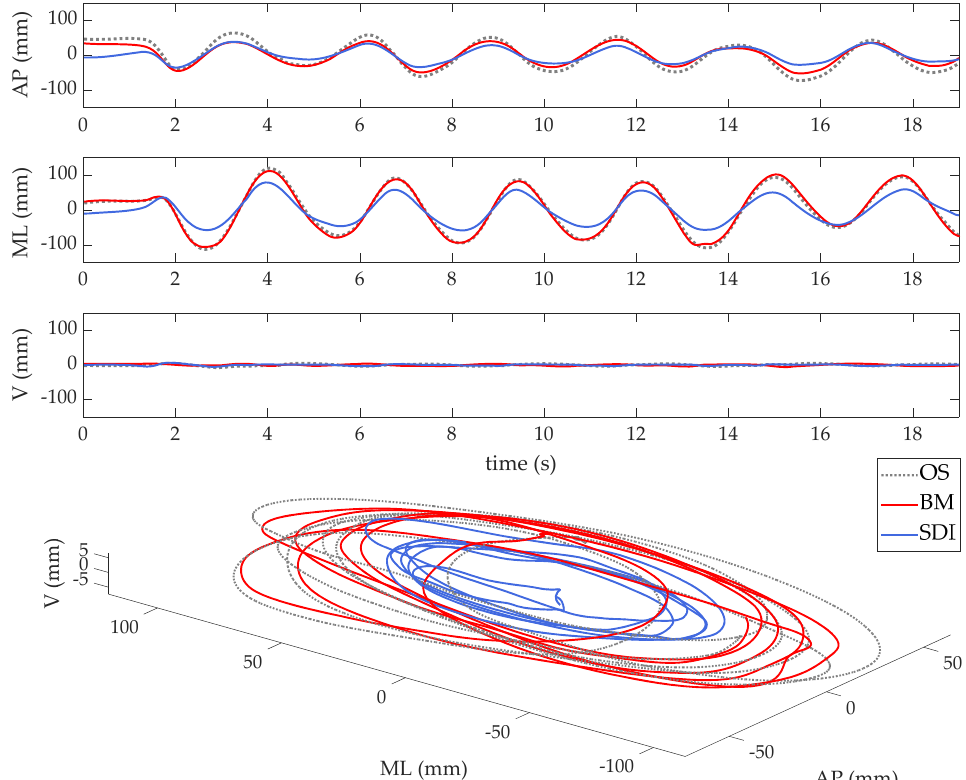
Figure 4. CoM trajectory of a Free Sway task (anteroposterior, AP; mediolateral, ML; and vertical, V, directions) performed by a representative subject, as obtained through the Biomechanical Model (BM, red) and the Strapdown Integration Method (SDI, blue), as compared to the gold standard (the optoelectronic system, OS, dotted black line).